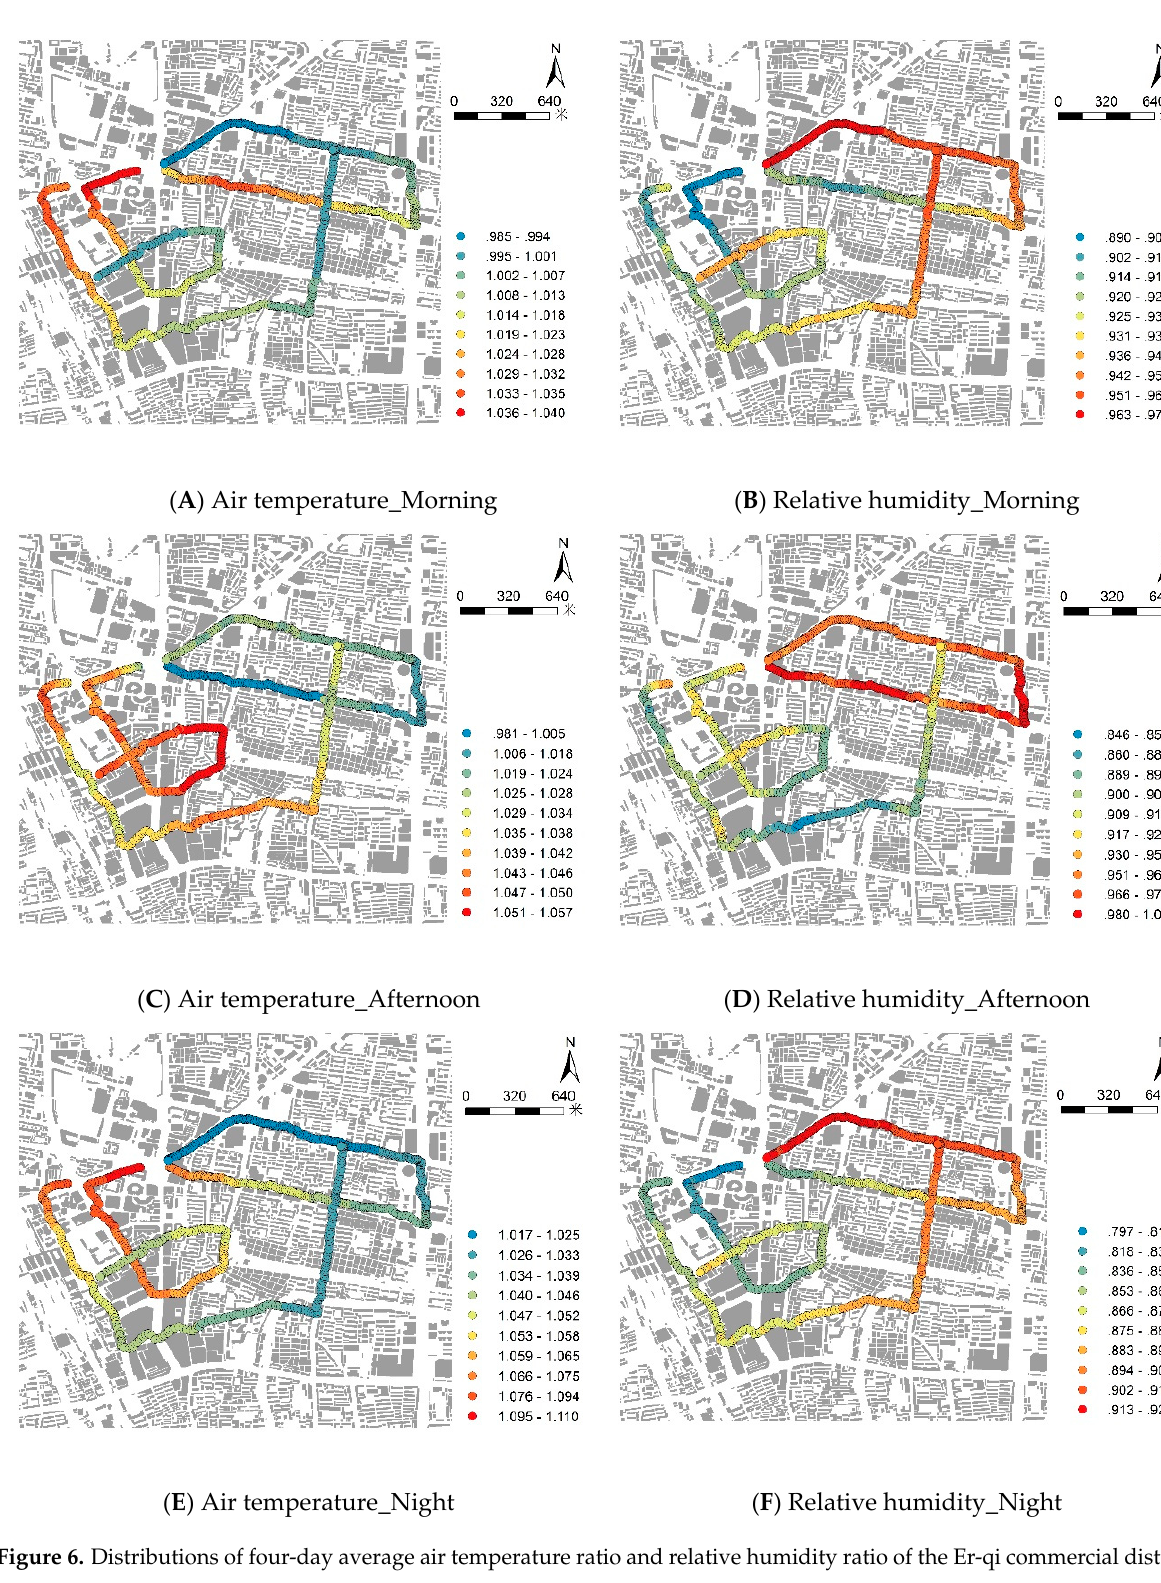
Figure 6. Distributions of four-day average air temperature ratio and relative humidity ratio of the Er-qi commercial district.